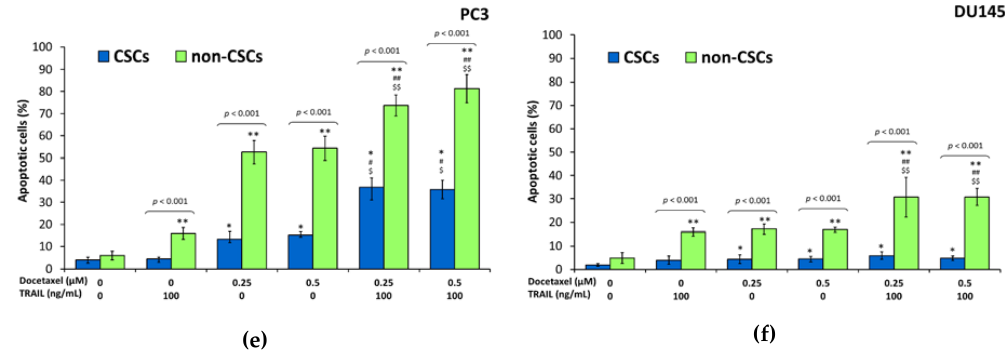
Figure 4. Apoptotic effect of TRAIL (100 ng/mL) in combination with paclitaxel, cabazitaxel and docetaxel in CSCs and non-CSCs subpopulations within DU145 and PC3 prostate cancer cells. The values represent mean ± SD ( n = 6). Within CSCs subpopulation: * p < 0.05, significantly different from the respective control; # p < 0.05, significantly different from TRAIL alone. $ p < 0.05, significantly different from respective taxane alone. Within non-CSCs subpopulation: ** p < 0.05, significantly different from the respective control; ## p < 0.05, significantly different from TRAIL alone. $$ p < 0.05, significantly different from respective taxane alone. ( a ) Apoptotic effect of TRAIL (100 ng/mL) in combination with paclitaxel, within CSCs and non-CSCs subpopulations in PC3 prostate cancer cells; ( b ) Apoptotic effect of TRAIL (100 ng/mL) in combination with paclitaxel, within CSCs and non-CSCs subpopulations in DU145 prostate cancer cells; ( c ) Apoptotic effect of TRAIL (100 ng/mL) in combination with cabazitaxel, within CSCs and non-CSCs subpopulations in PC3 prostate cancer cells; ( d ) Apoptotic effect of TRAIL (100 ng/mL) in combination with cabazitaxel, within CSCs and non-CSCs subpopulations in DU145 prostate cancer cells; ( e ) Apoptotic effect of TRAIL (100 ng/mL) in combination with docetaxel, within CSCs and non-CSCs subpopulations in PC3 prostate cancer cells; ( f ) Apoptotic effect of TRAIL (100 ng/mL) in combination with docetaxel, within CSCs and non-CSCs subpopulations in DU145 prostate cancer cells.